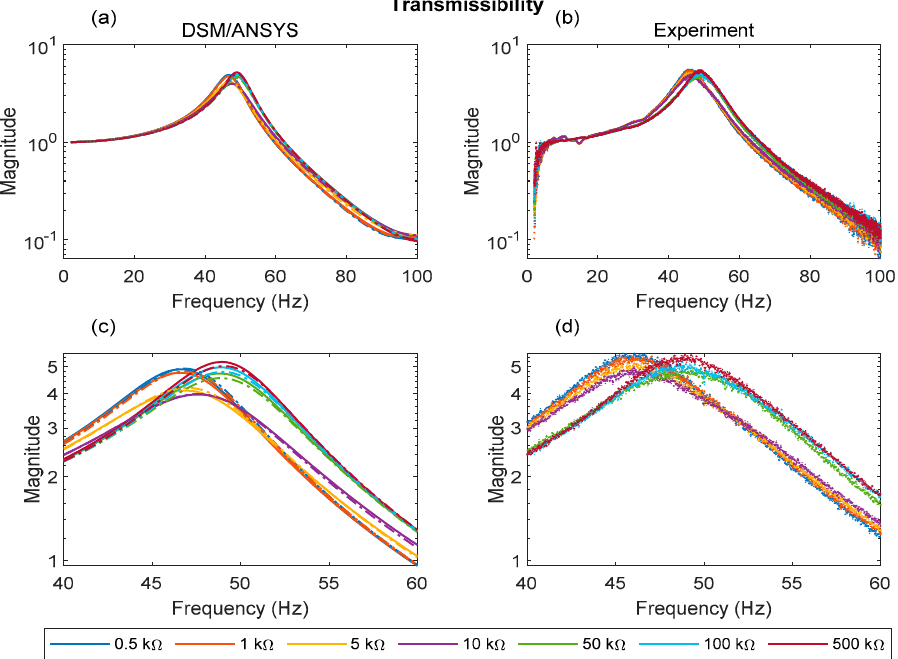
Figure 11. Analytical and experimental transmissibility FRF for different electrical loads: ( a ) DSM/ANSYS; ( b ) experiment; ( c ) DSM/ANSYS result zoomed in resonance region; ( d ) experimental result zoomed in resonance region (dashed and solid lines in ( a , c ) represent data associated with ANSYS plane element model and DSM, respectively).